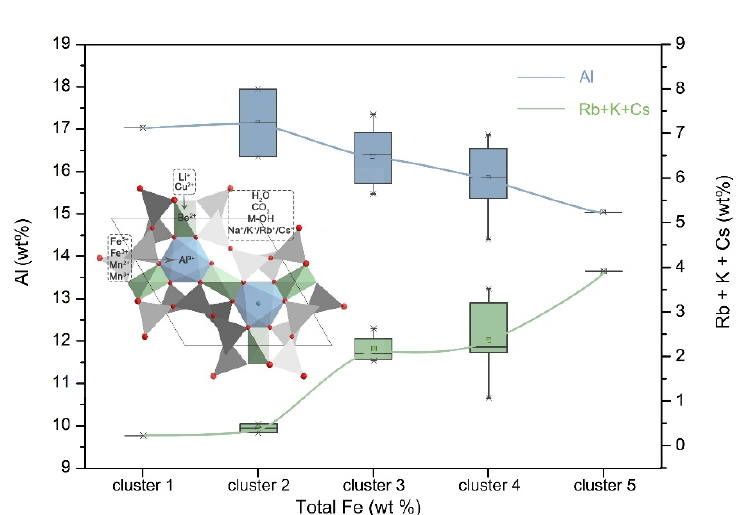
Figure 8. Box diagram of the relationship between the weight contents of total Fe, Al and alkali ions. K-means clustering were used to divide the data into different groups and every box represents the data within a group. A schematic diagram of the chemical group occupation in beryl also showed in the figure.